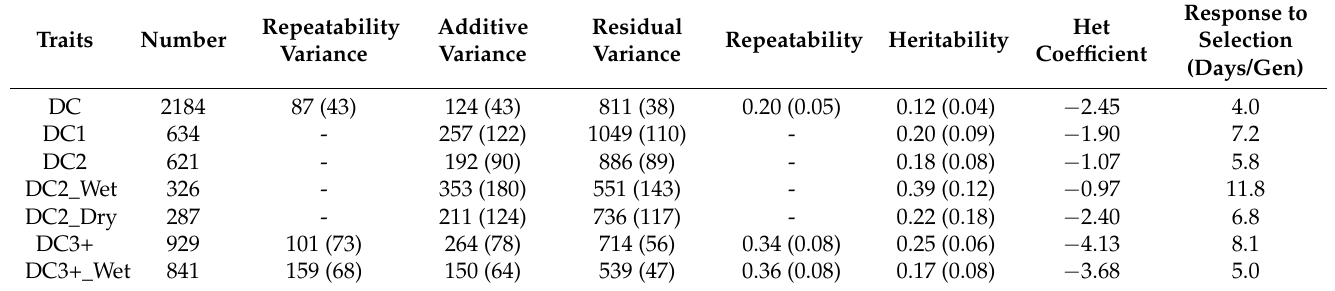
Table 10. Variance components, repeatability, heritability and heterozygosity (Het) coefficient of days to calving traits with standard error in parenthesis.